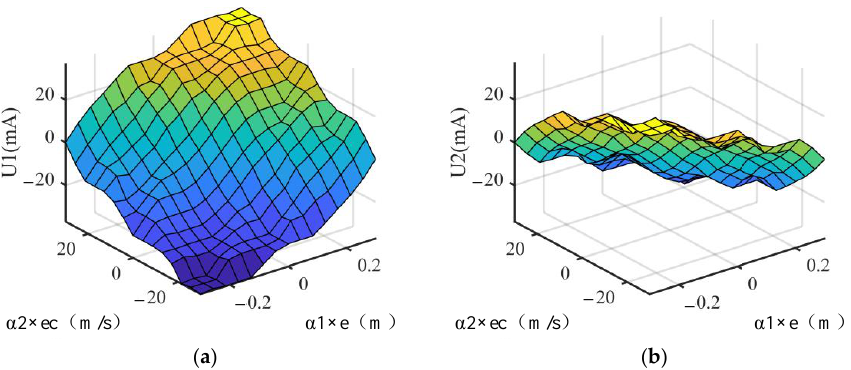
Figure 10. Mapping relationship between input variables and output variables of the fuzzy controller I. ( a ) Mapping of input variables to U1 . ( b ) Mapping of input variables to U2 .